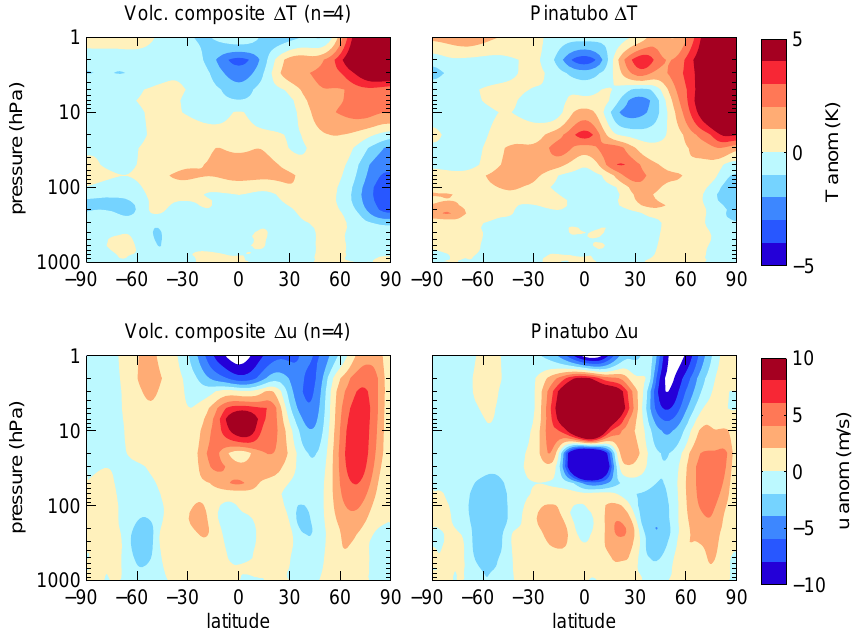
Figure 1. ERA-Interim DJF (top) temperature and (bottom) zonal wind anomalies for (left) post-volcanic composite ( n = 4) of two winters after eruptions of El Chichón and Pinatubo, and (right) 1991/92, the first winter after the Pinatubo